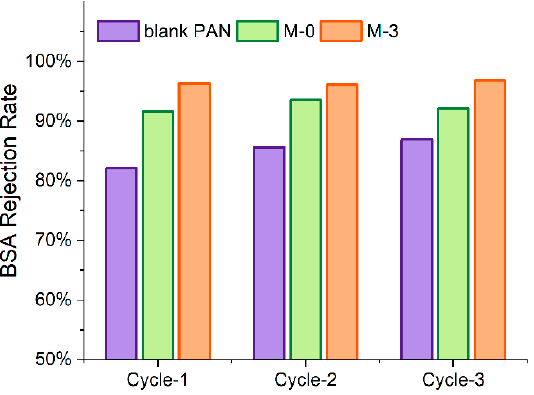
Figure 10. The BSA rejection rate of the blank PAN, M-0 and M-3 membranes across the filtration